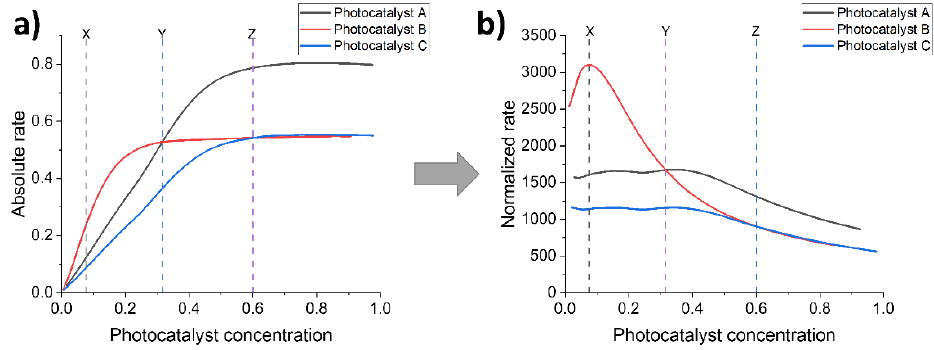
Figure 44. ( a ) Absolute and ( b ) mass normalized photocatalytic rates of catalysts.